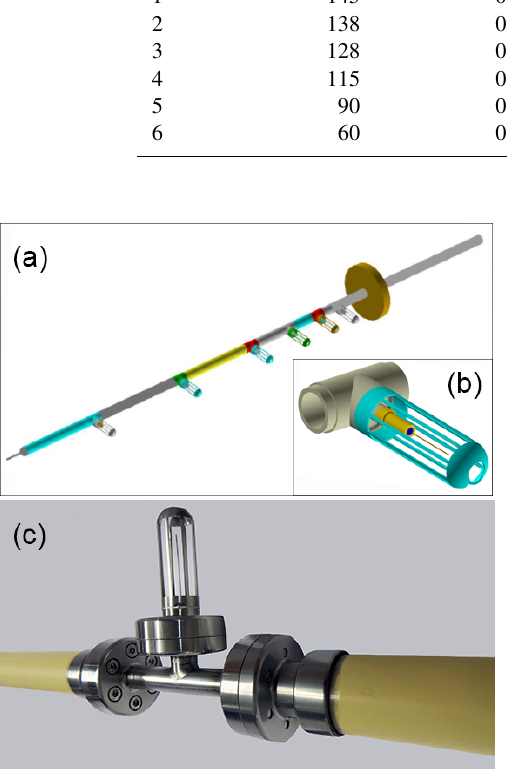
Figure 2. Images of two temperature strings showing (a) a model drawing of the thermocouple (TC) string with six TC sensors and one Pt100 sensor at the tip mounted on a 1.25m stainless steel support tube welded to a DN100 flange, (b) a model drawing of a single TC sensor (thin brown line) and (c) a photograph of an approximately 25cm section of the optical sensor string showing a sensor mounted inside a stainless steel capillary and transition structure that is welded to two partially conducting zirconia ce- ramic tube spacers of 27mm outer diameter (yellow). The sensors are mounted inside Faraday cages (e.g. coloured blue in panel b ) to protect against corona discharge when a 20kVcm − 1 vertical elec- tric field is present in the CLOUD chamber. Ultra-clean materials (stainless steel and ceramics) are used throughout, with the readout wires/optical fibres passing inside the hollow support structures.